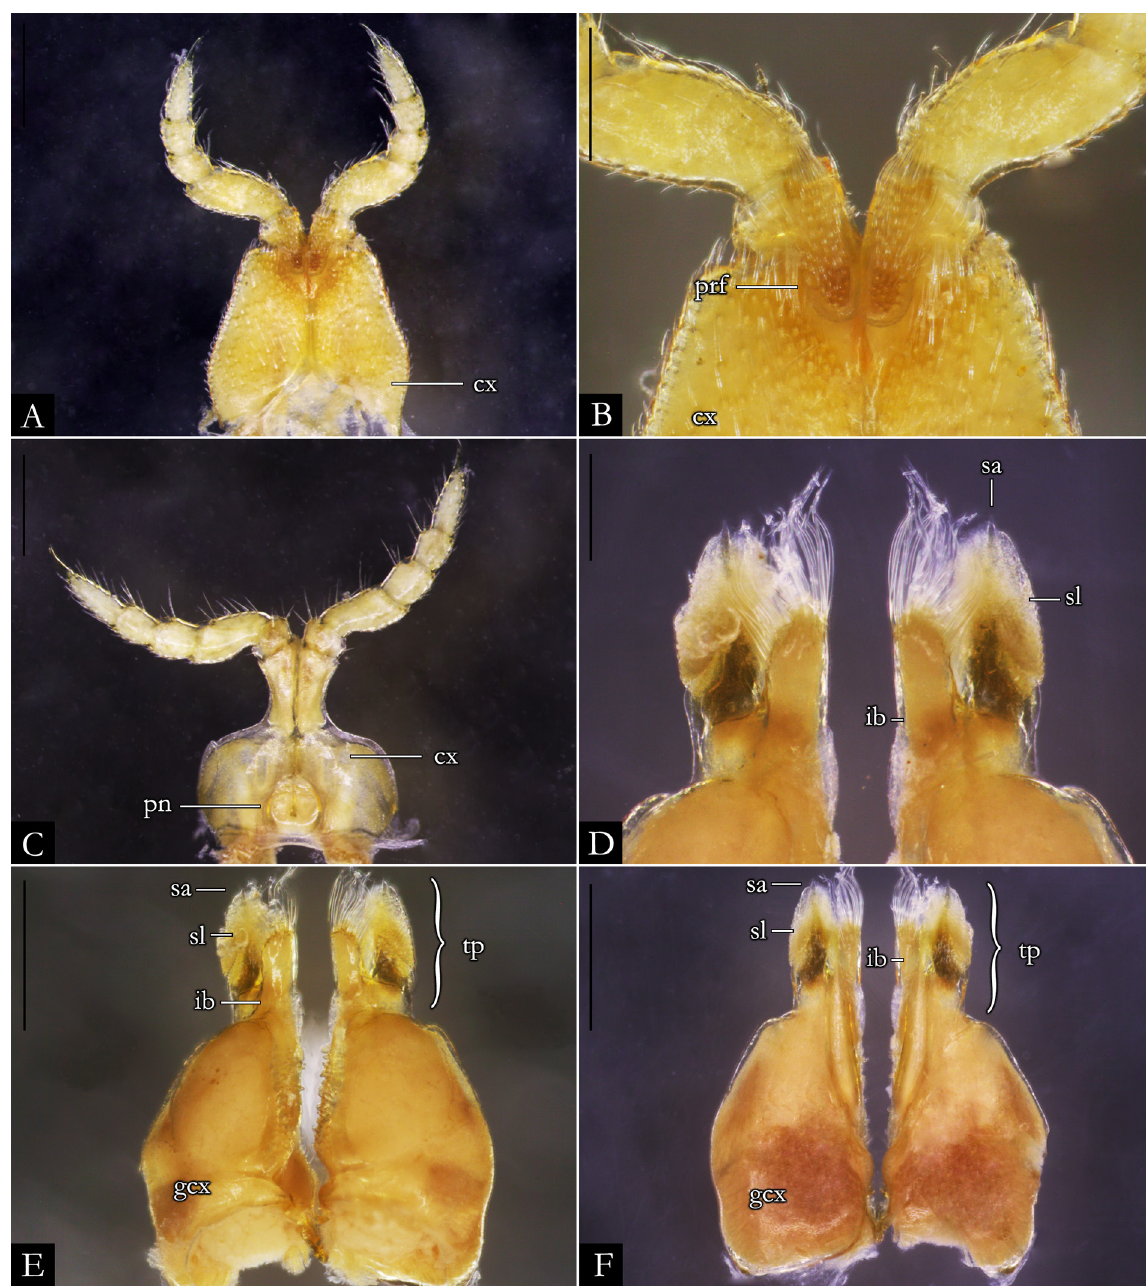
Fig. 47. Pseudonannolene ambuatinga Iniesta & Ferreira, 2013, ♂ (IBSP 3442). A . First leg-pair. B . Detail of prefemur. C . Second leg-pair. D . Detail of telopodites, in anal view. E . Gonopods, in anal view. F . Gonopods, in oral view. Abbreviations: see Material and methods. Scale bars: A, C, E–F = 0.5 mm; B, D = 0.2